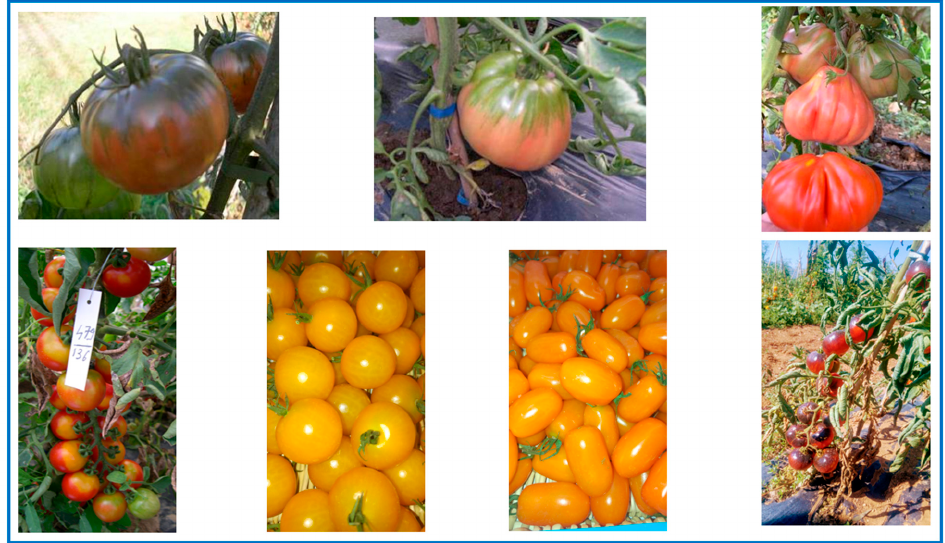
Figure 2. Examples of tomato diversity for SLL and SLC types on the top and on the bottom of the picture, respectively.